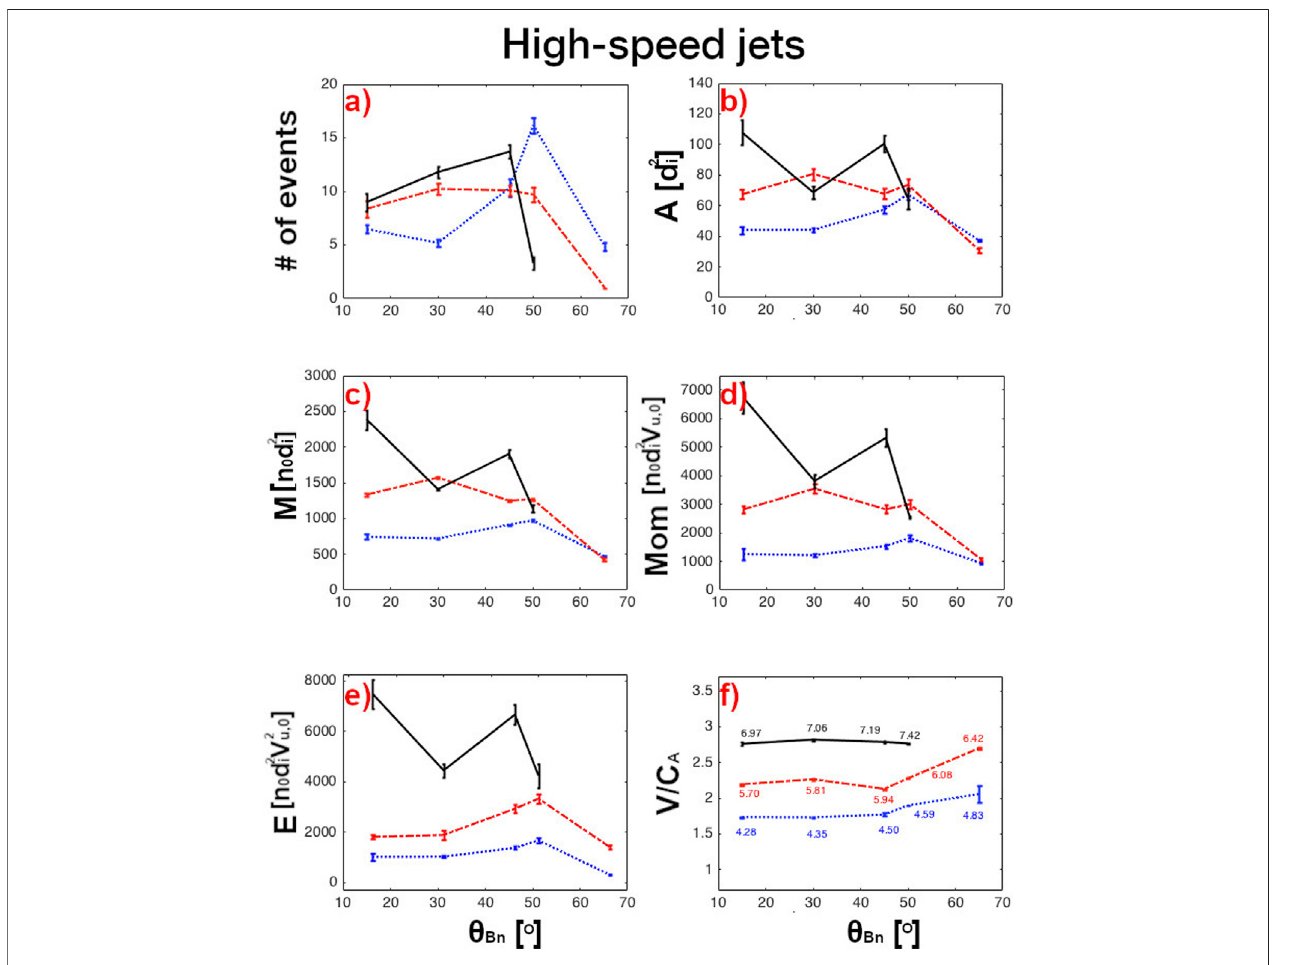
FIGURE 3 | Average properties of high-speed jets as a function of θ BN . The panels from (A – F) show: number of events, area, mass, linear momentum, kinetic energy and jet velocity normalized to C A . Vertical lines represent error of the mean. Shock M A are added on panel (F) . The blue, the red and the black traces represent properties of jets produced in runs with V in = 3.3 C A , 4.5 C A and 5.5 C A respectively. The units are given in brackets. The subindex u refers to the upstream region, while the subindex 0 means the initial value.